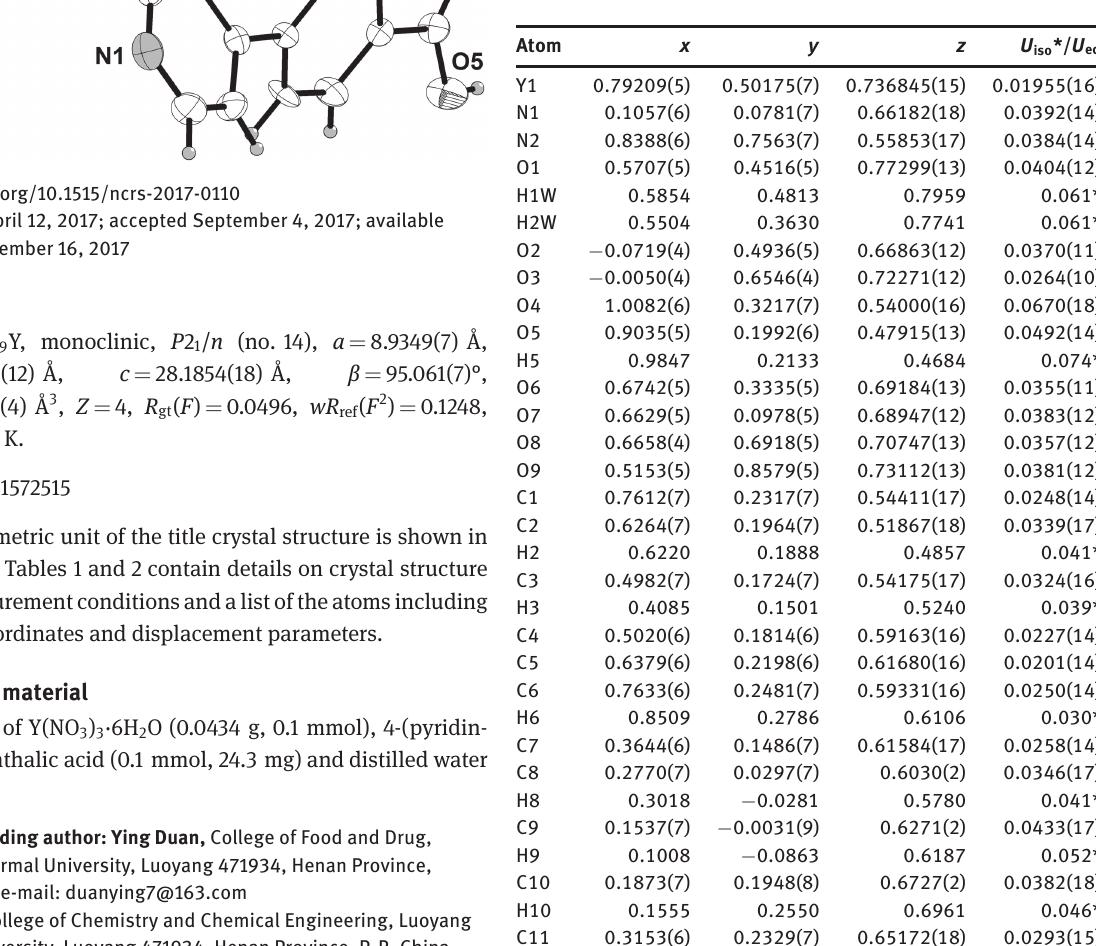
Table 2: Fractional atomic coordinates and isotropic or equivalent isotropic displacement parameters (Å 2